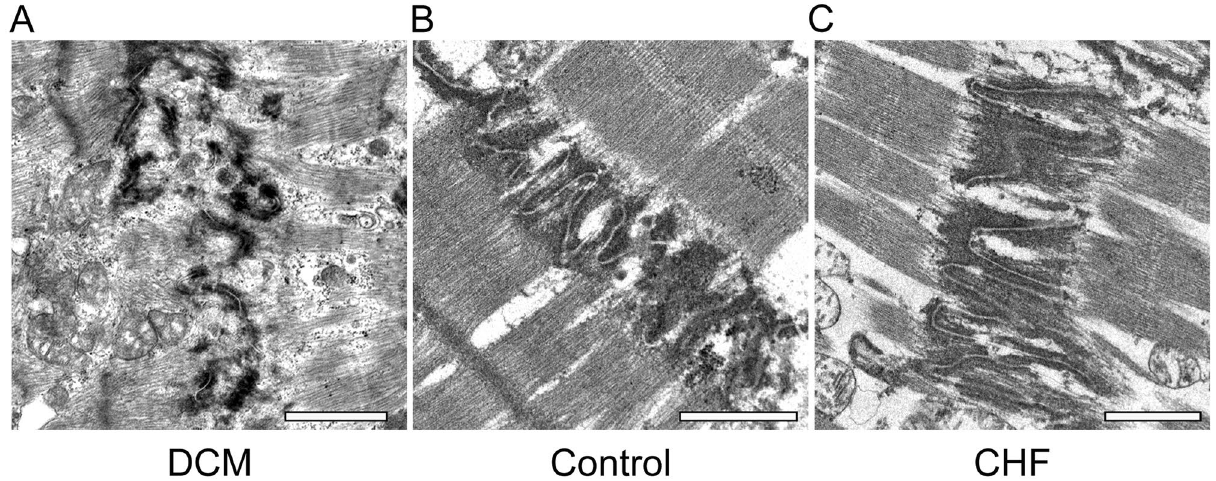
Figure 4. Transmission electron microscopy findings of intercalated discs in each group. ( A ) In the DCM group, ICDs were deteriorated and disorganized, the interdigitation of ICDs was disrupted throughout the tissue, and the junctions between cardiomyocytes and ICDs were obscured. Sarcomeres were arranged in a complex manner (scale bar, 1 μm; original magnification, × 6000). ( B ) In the control group, ICD ultrastructure was preserved. The finger-like folds of ICDs, called interdigitation, repeated at regular intervals (scale bar, 1 μm; original magnification, × 6000). ( C ) In the CHF group, ICDs were wider than in the control group, about two sarcomere widths. However, ICD ultrastructure as preserved. Interdigitation of ICDs was retained (scale bar, 1 μm; original magnification, ×